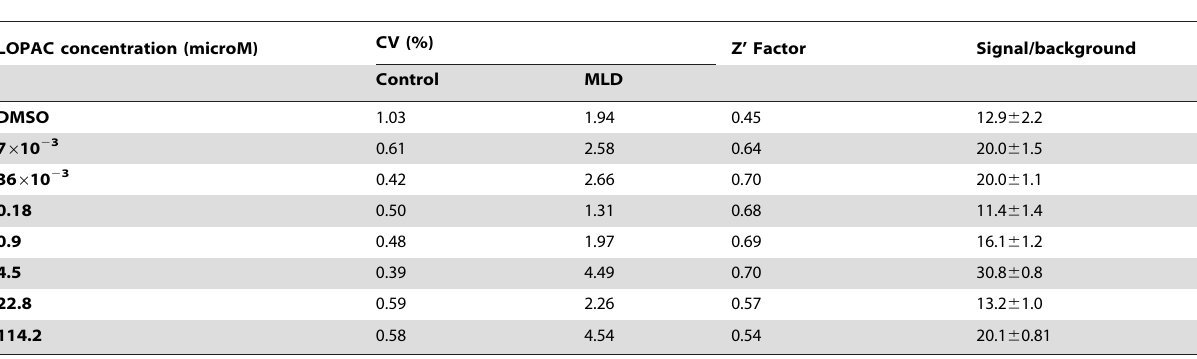
Table 2. Statistical parameters of the quantitative cell-based HTS for ASA.